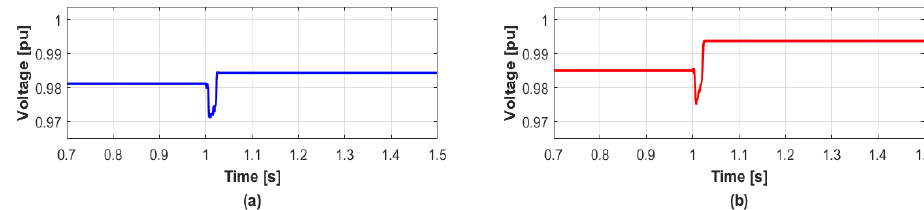
Figure 10. Voltage responses without the reactive power compensation in Case 3. ( a ) Bus 2 ( b ) Bus 3.